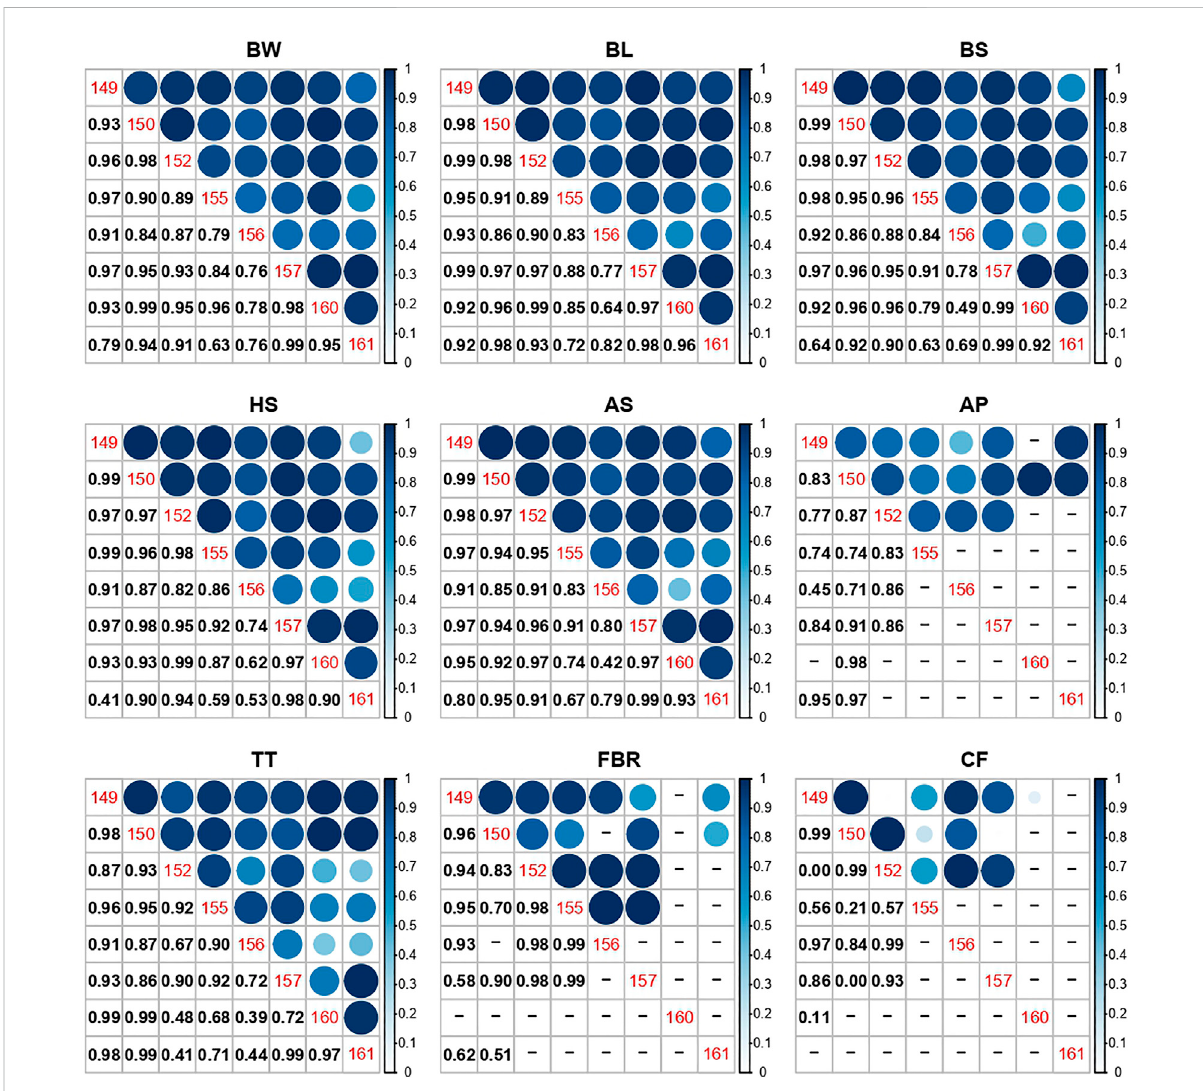
FIGURE 2 Correlation plots of estimated genetic correlations of traits between pairs of ponds, as a measure of G × E. Pond numbers are shown down the diagonal,withnumericalvaluesbelowthediagonal,andcorrelationvisualisationabove.Valuesshownas “–” arewheretheparticularbivariatemodel could not be fi tted. Trait codes are BW = body weight (g); BL = body length; BS = body size; HS = head size; AS = abdomenal size; AP = abdominal percentage;TT=tailtip;FBR=front-backratio;CF=conditionfactor.Conditionfactorlength(CFL)notshownasonlyonecorrelationcouldbe estimated (Ponds 149 and 152: r g =